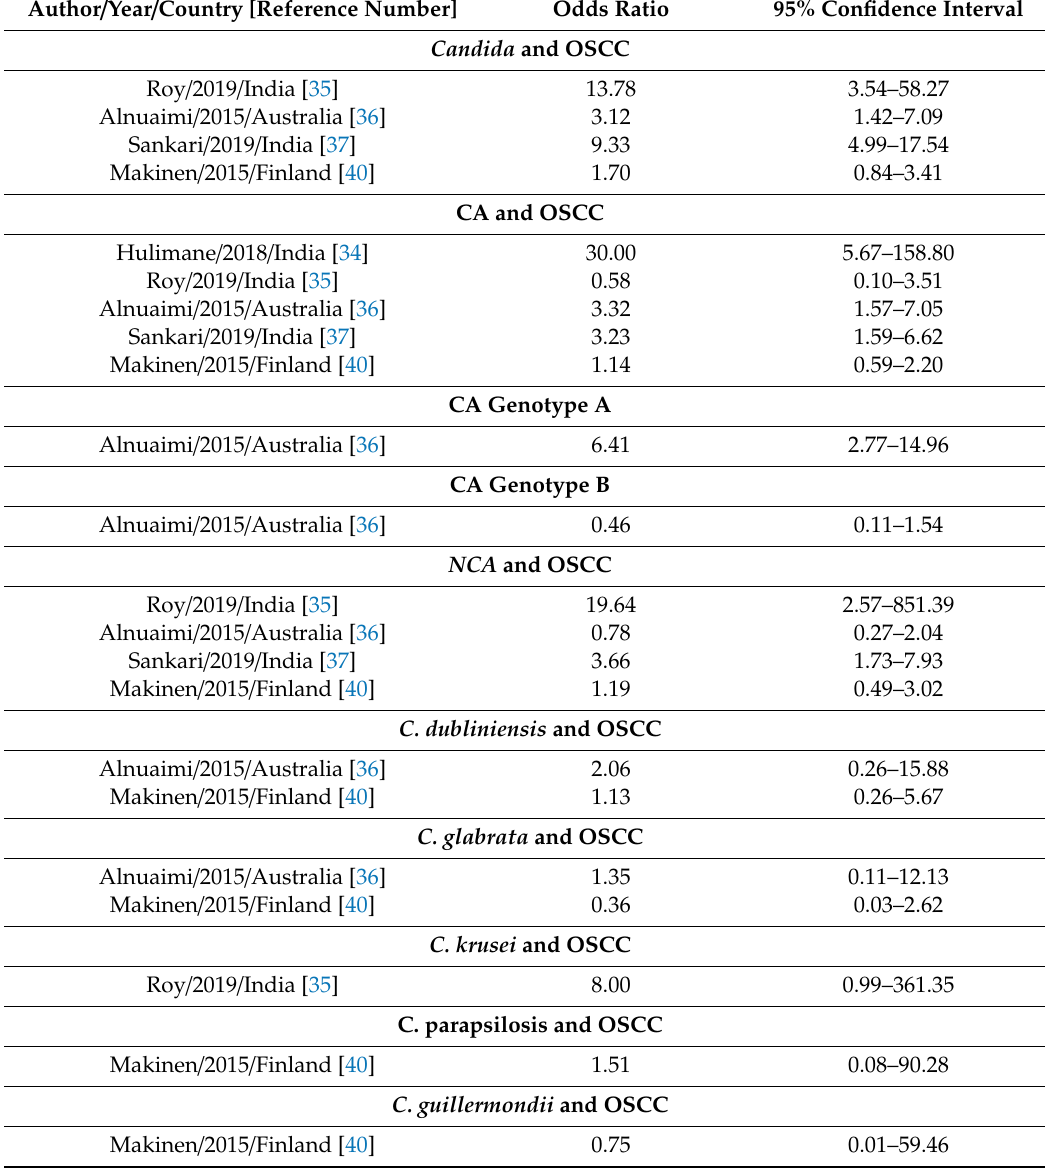
Table 3. Odds ratio and confidence interval calculated for Candida prevalence and species specificity from each study included in the systematic review.